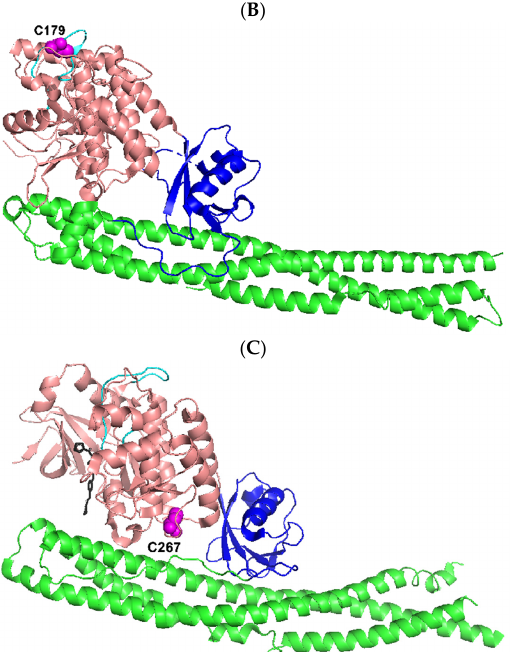
Figure 9. Ribbon diagram representation of the X-ray crystal structures of three truncated human IKK kinases generated by using PYMOL [68]. The N-terminal KD (salmon) including its activation loops (cyan), ULD (blue), and SDD (green) are shown while the CTD is missing. ( A ) IKK α (residues 6–660) (PDB: 5EBZ) [35]. The phosphoacceptor sites S176 and S180 of the kinase activation loop (cyan) were mutated to glutamate to mimic their phosphorylation status. HCV NS3/NS4A was predicted to cleave after C178 (magenta, spheres) within the kinase action loop and C379 (magenta, spheres) in the ULD (Table 1). ( B ) IKK β (residues 1–671) complexed with a staurosporine analog inhibitor K252a (black) (PDB: 4KIK) [69]. The kinase activation loop (cyan) has three disordered residues (residues 174–176) and its phosphoacceptor sites (S177 and S181) were phosphorylated. NS3/NS4A was predicted to cleave after C179 (magenta, spheres) within the kinase action loop (Table 1). ( C ) TBK1 (residues 1–657) complexed with a specific inhibitor BX7 (black) (PDB: 4IW0) [38]. The kinase activation loop (cyan) was well ordered and its sole phosphoacceptor site S172 was phosphorylated. NS3/NS4A was predicted to cleave after C267 (magenta, spheres) within the KD (Table 1).